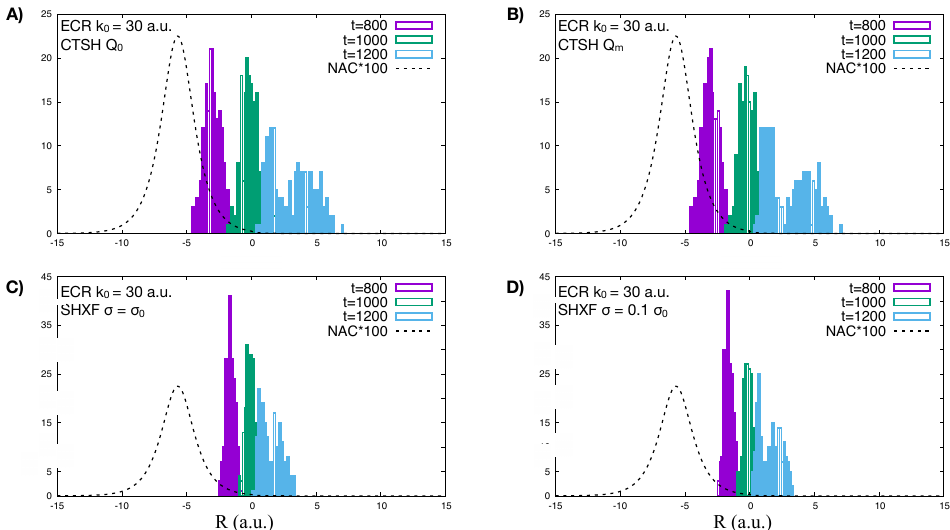
Figure 4. Spatial distribution of trajectories for the ECR model with k 0 = 30 a.u.: CTSH with original definition of the quantum momentum using Equation (22) (panel A ), CTSH with the modified definition of the quantum momentum using Equation (27) (panel B ), SHXF with σ = σ 0 (panel C ) and SHXF σ = σ 0 /10 (panel D